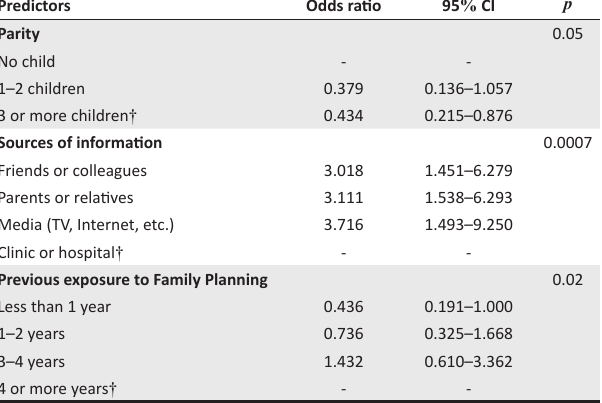
TABLE 3: Logistic regression results for determinants of contraception use.